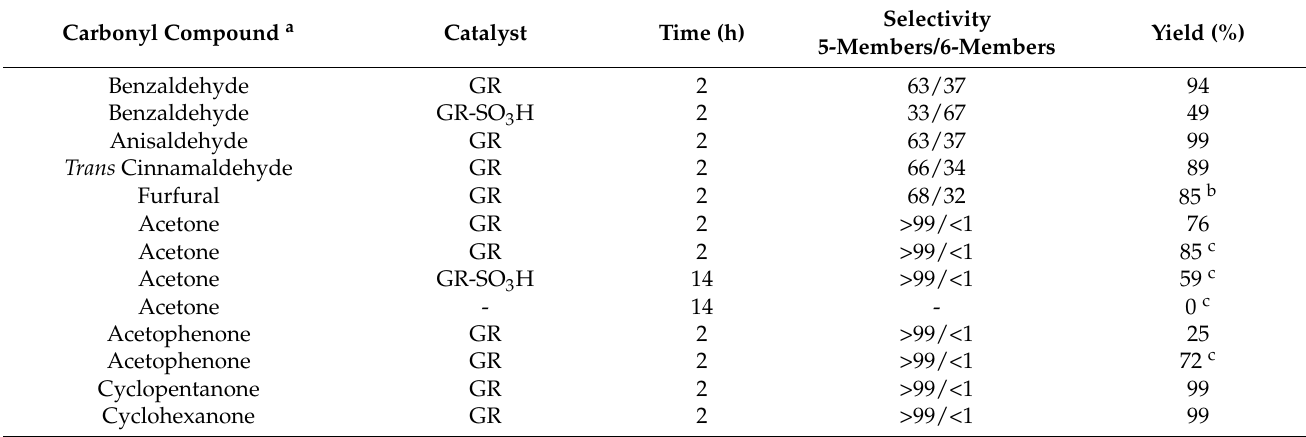
Table 8. Acetalization of glycerol with carbonyl compounds.